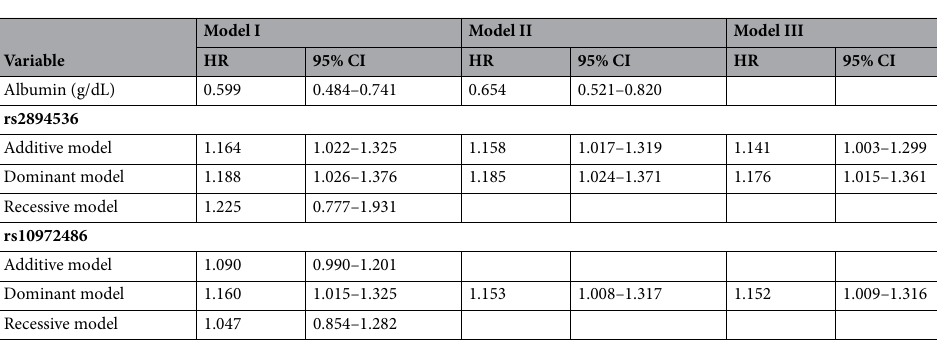
Table 4. Multiple Cox proportional hazard model for hypertension (HTN) a development. Model I: adjusted for age, sex, and smoking history. Model II: adjusted for age, sex, smoking history, systolic BP, diastolic BP, body mass index, waist circumference, hemoglobin, platelet, hemoglobin A1c, alanine aminotransferase, γ-glutamyl transferase, triglyceride, and HDL-cholesterol levels. Model III: adjusted for age, sex, smoking history, systolic BP, diastolic BP, body mass index, waist circumference, hemoglobin, platelet, albumin, hemoglobin A1c, alanine aminotransferase, γ-glutamyl transferase, triglyceride, and HDL-cholesterol levels. HR, hazard ratio; CI , confidence interval. a Defined as BP ≥ 140/90 mmHg and/or antihypertensive drug therapy during the follow-up